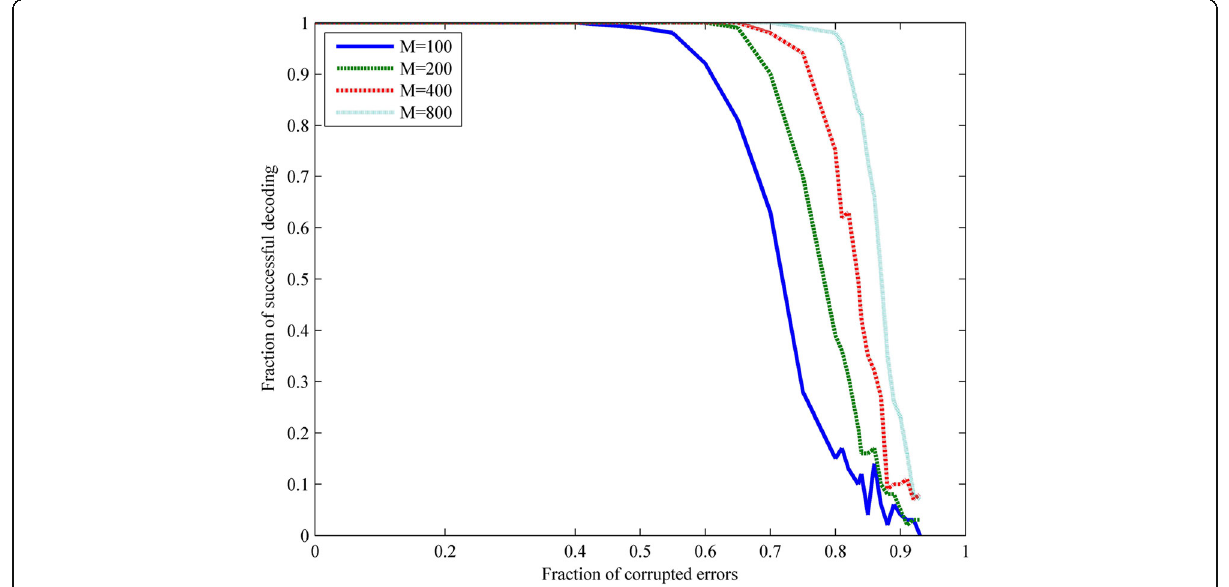
Fig. 3 Error correction in L1 optimization when ‖ x 0 ‖ = 1. Legend ( ‘ M = 100 ’ , ‘ M = 200 ’ , ‘ M = 400 ’ , ‘ M = 800 ’